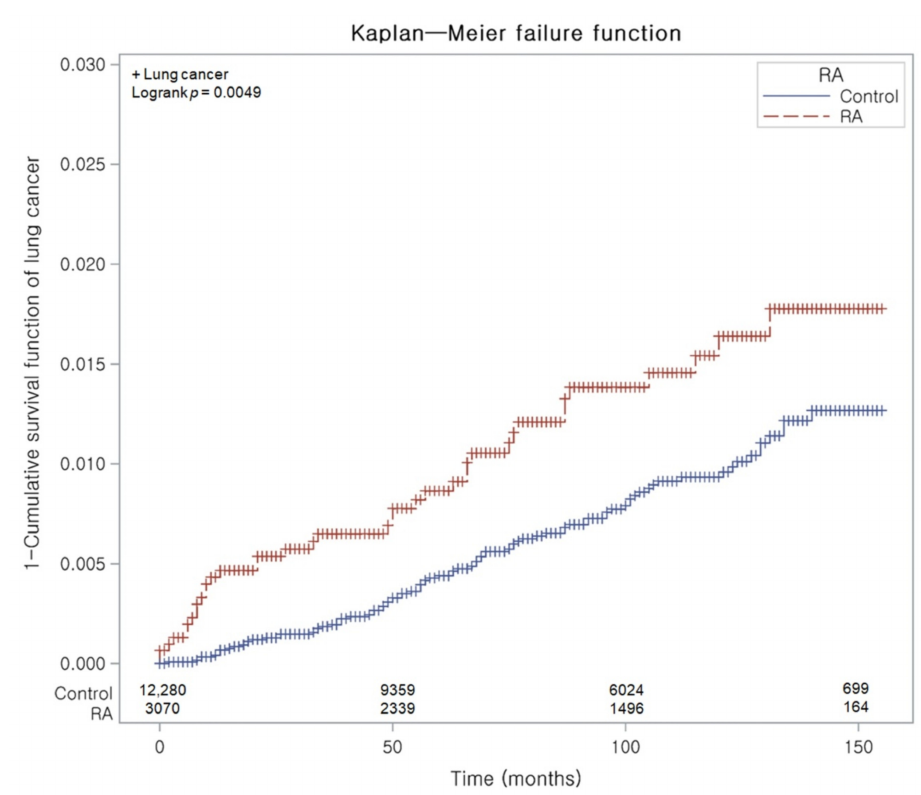
Figure 2. Kaplan–Meier probability of the incidence of lung cancer in the rheumatoid arthritis (RA) population and in controls during a 14-year period commencing from the index